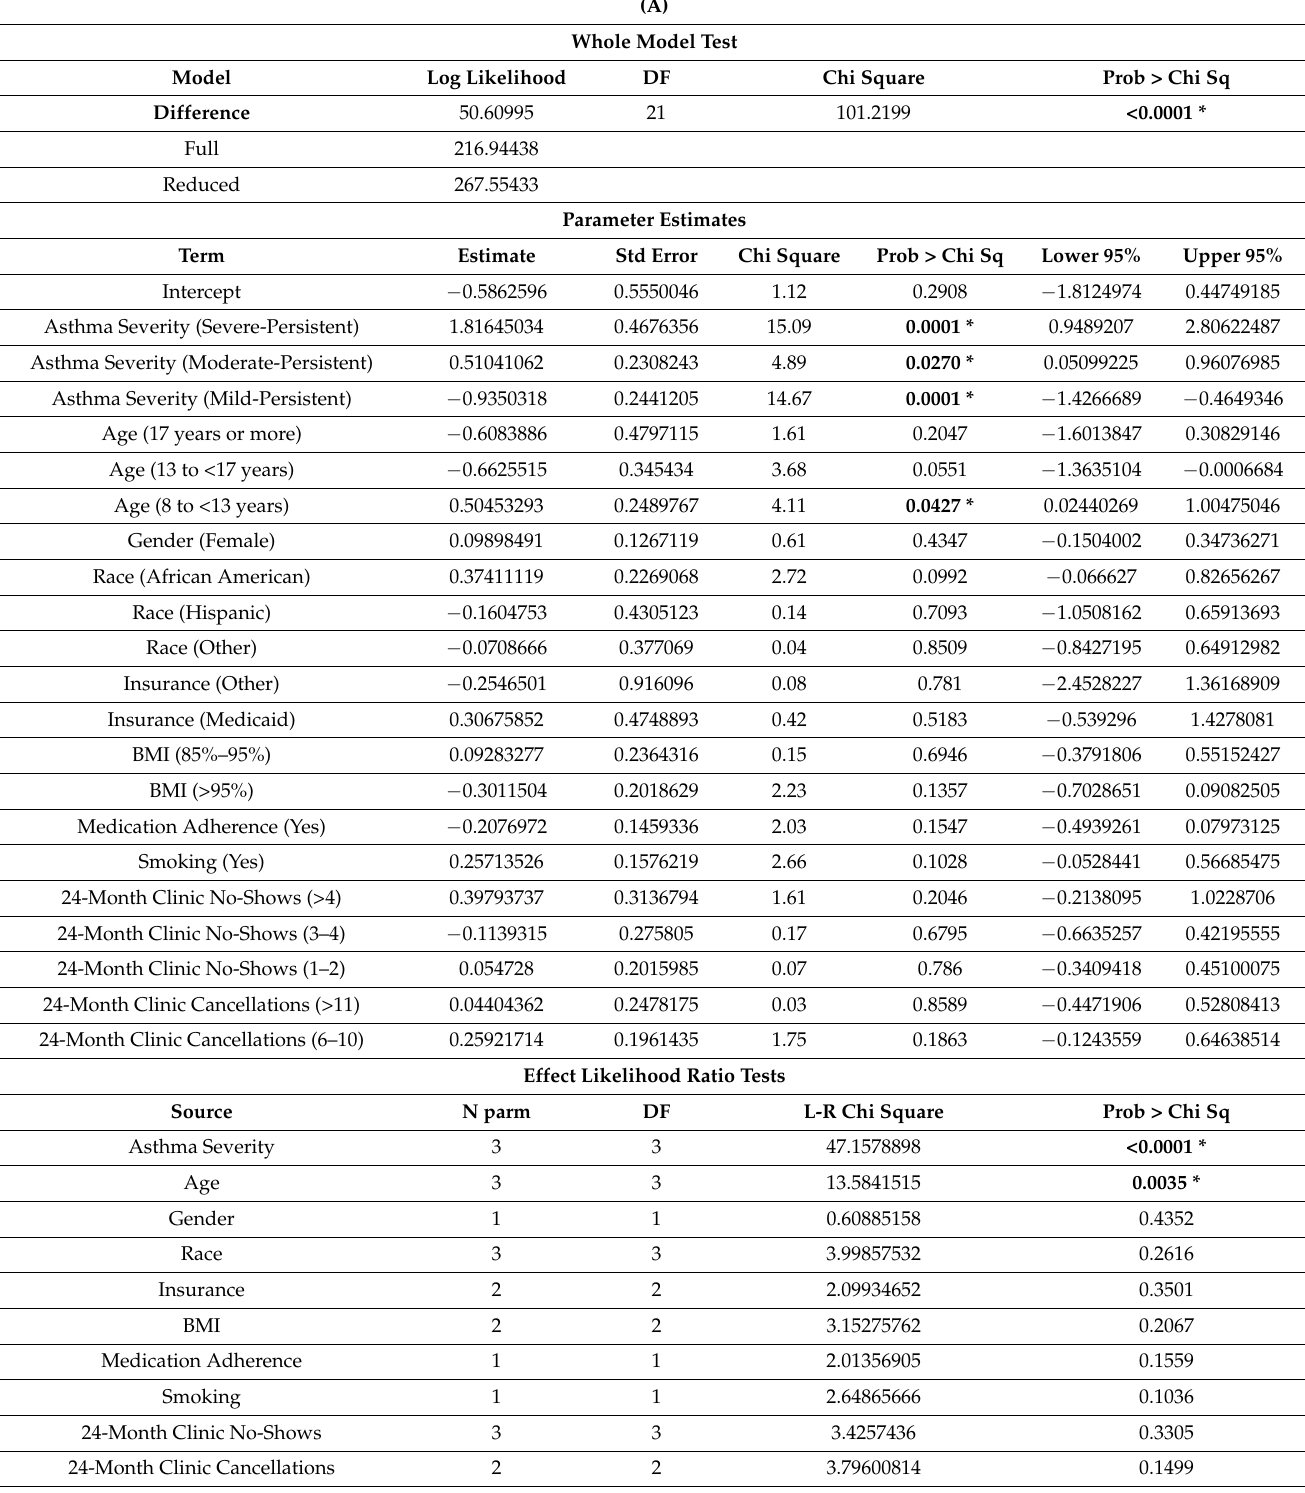
Table 4. ( A ) Logistic Regression Output for DV3 (Part 1). ( B ) Logistic Regression Output for DV3: Odds of User vs. Non-User (Part